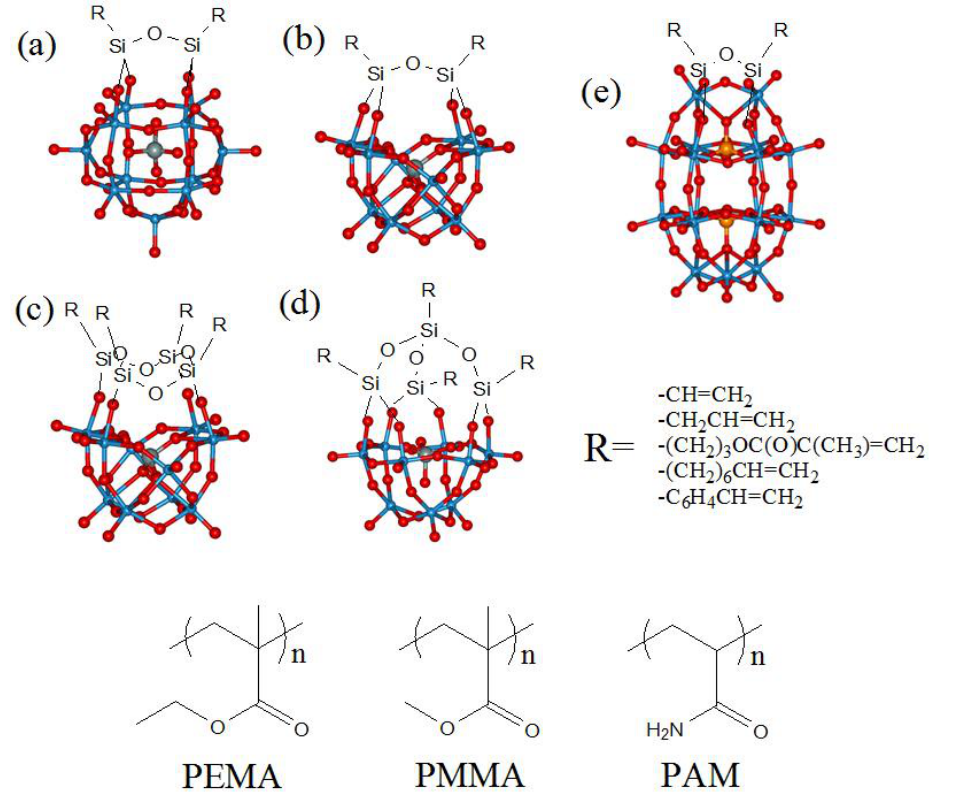
O (RSi) O] 4− ; ( b ) bis- and 11 39 2 O (RSi) O] 4− ; and ( c ) [γ-SiW O (RSiO) ] 4− ; 10 36 2 10 36 4 O (RSi) O ] 4− ; ( e ) 9 34 4 3